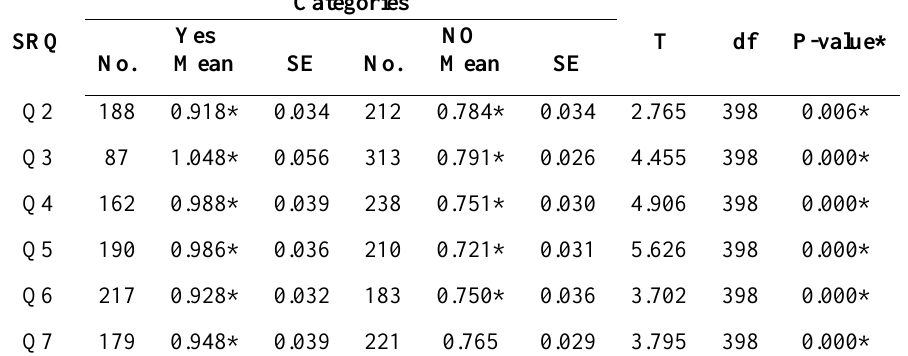
Table (3) ׃ Descriptive and statistical test of Plaque index among questionnaire